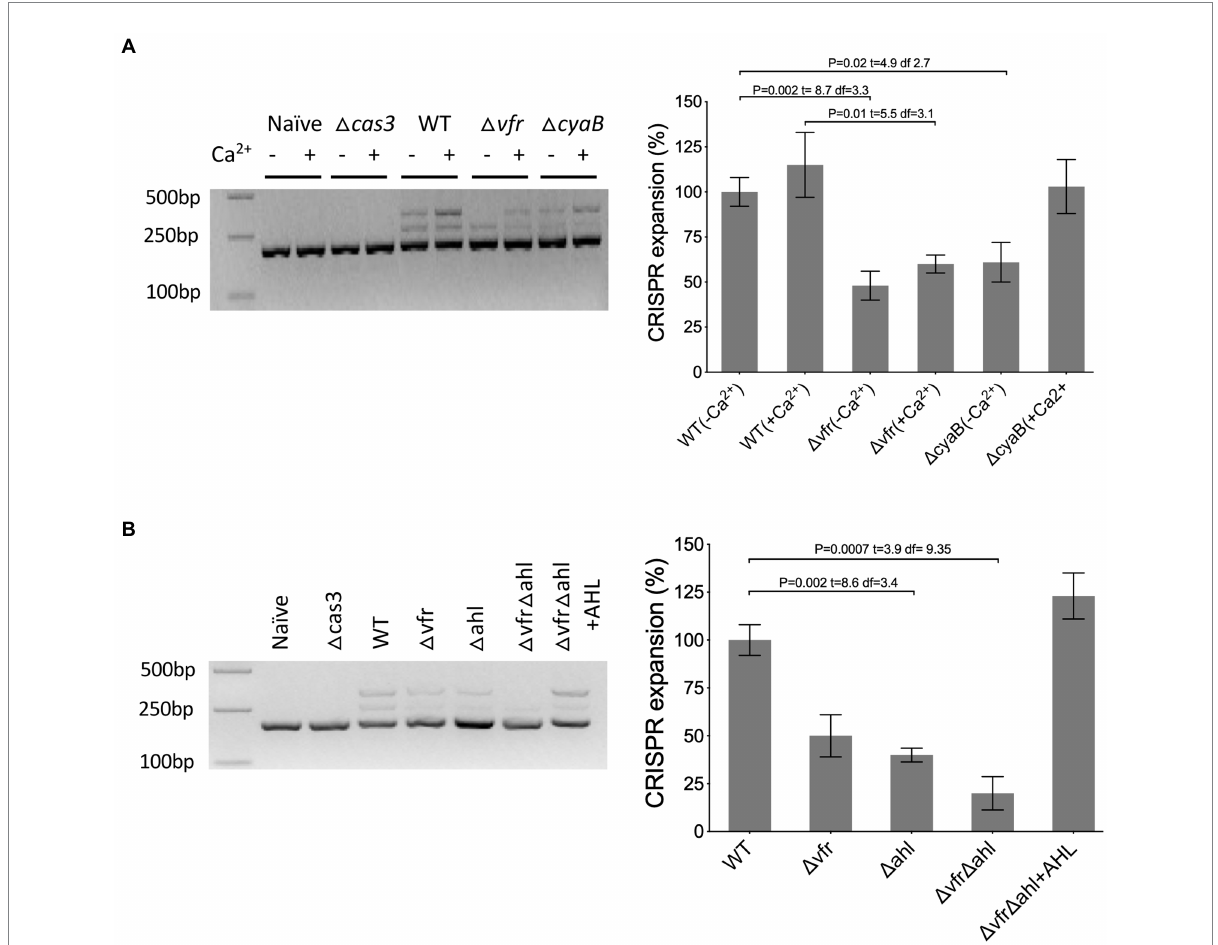
FIGURE 6 Vfr regulates CRISPR-Cas spacer acquisition. (A , B) Acquisition of spacers in the CRISPR2 locus was identified by PCR of transconjugants after 5 days of passage with the CRISPR-targeted plasmid. As a negative control, wild-type and cas3 mutant were transformed with the non-targeted plasmid (naïve) and targeted plasmid, respectively. The adaptation events are signified by expansion of the arrays and 60 bp extension of the CRISPR locus. The media for Δ vfr Δ ahl passage was supplemented with Exogenous QS molecules (+AHL). Figure presented is representative of three identical repeats. The intensity of the bands was quantified by image J software. The WT mean is normalized to 100%. Statistical analysis was conducted by student’s t -test with a p value of < 0.05 is considered